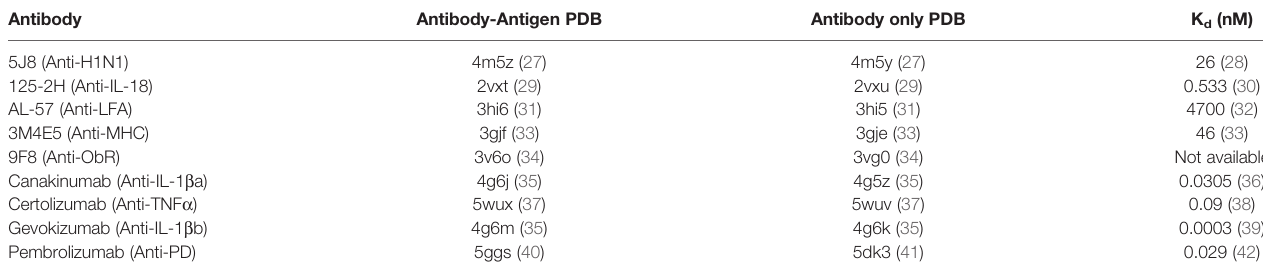
TABLE 1 | Antibody-antigen dataset structures. Names for referring to antibodies in the results and discussion are given in parentheses. Antibody Antibody-Antigen